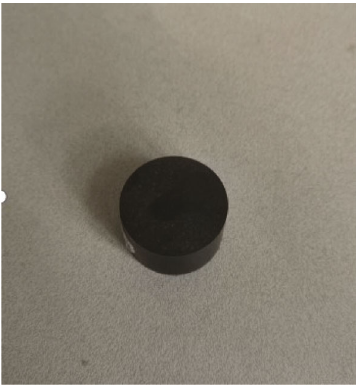
Figure 12: A sample of the prepared focal light fi lm